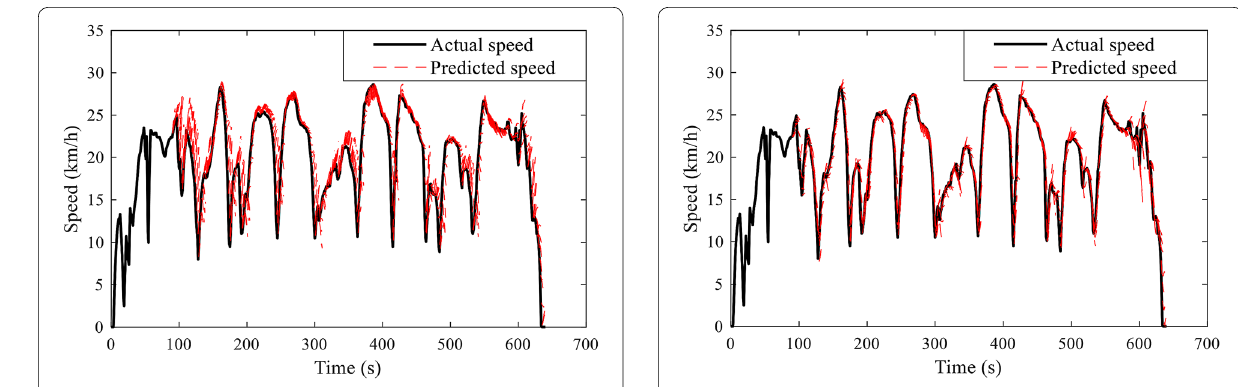
Figure 13 BP neural network speed prediction